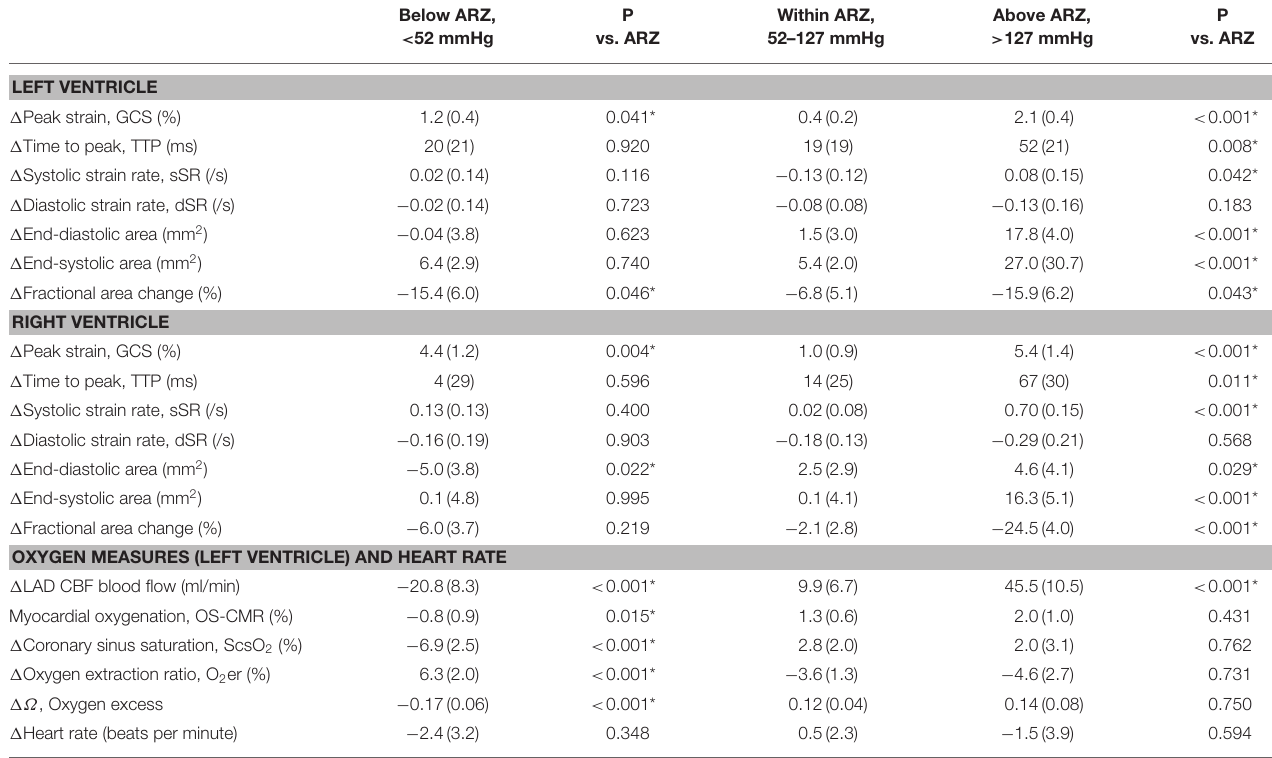
TABLE 1 | ANOVA comparisons for imaging and invasive measures below and above the autoregulation zone.